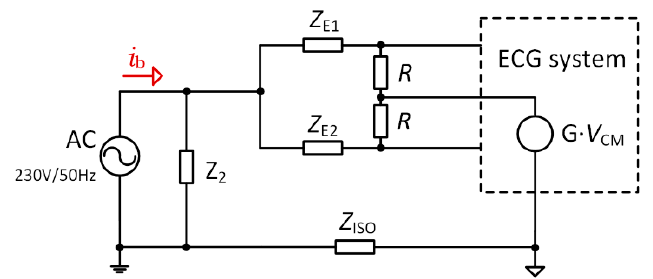
Figure 8. Equivalent circuit of the interference model using DRL.